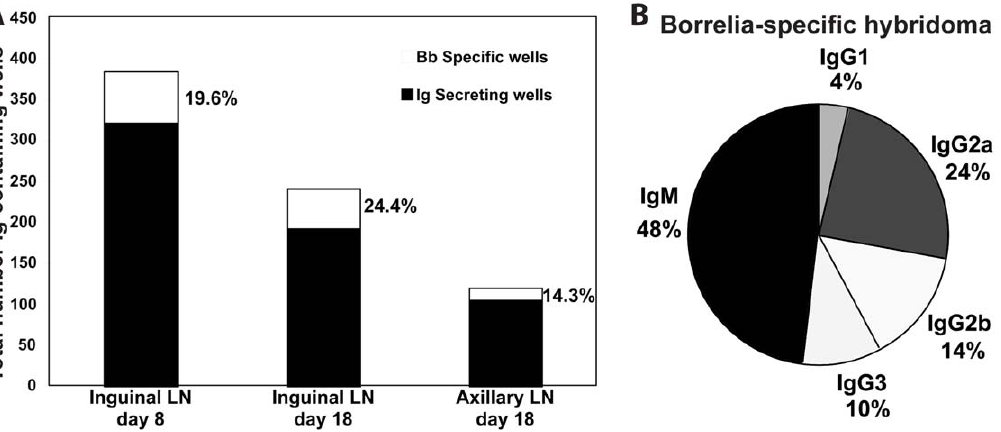
Figure 6. Lymph nodes of B.burgdorferi -infected mice contain large numbers borrelia-specific B cells. Shown are the results of three independent hybridoma fusion experiments. (A) Shown are stacked bars with the total number of antibody-secreting cells (black) and the number of lines generating B. burgdorferi -specific antibody as assessed by ELISA with four recombinant B. Burgdorferi antigens. Cells for the fusion were from indicated lymph nodes and times after infection with host-adapted spirochetes. (B) Indicated are the Ig-isotype distribution among all B. burgdorferi - specific hybridoma lines generated.